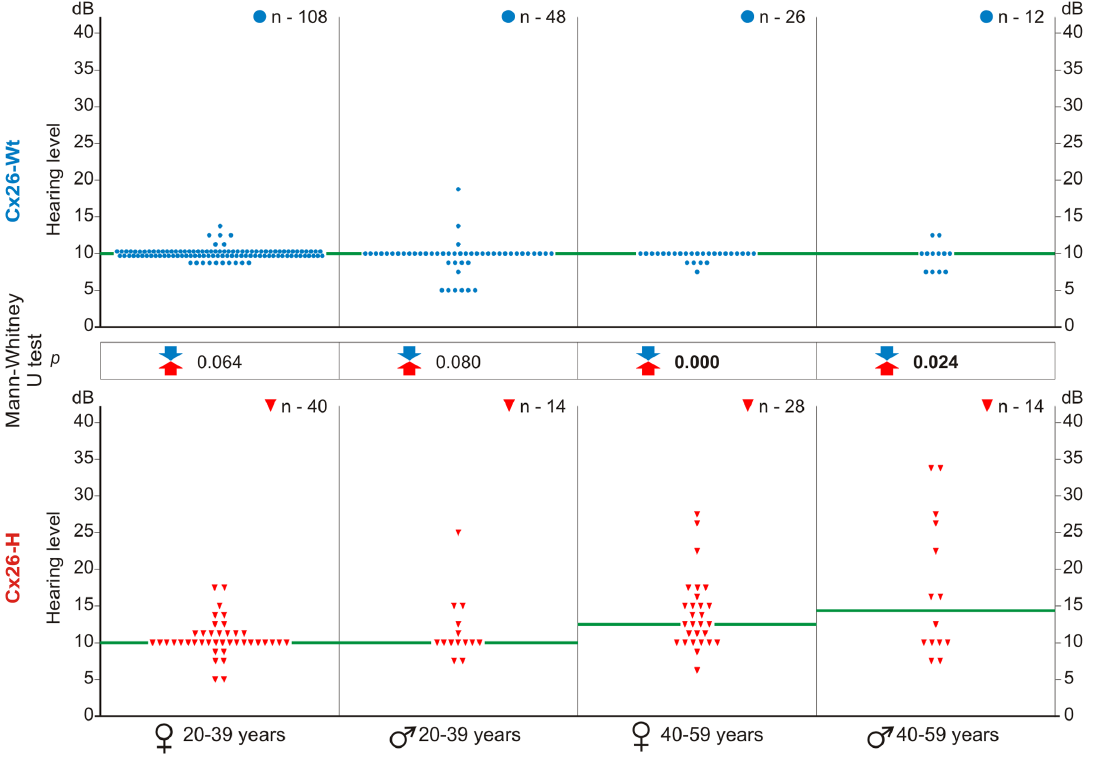
Figure 3. Scatter plots of the hearing thresholds at PTA 0.5, 1.0, 2.0, 4.0 kHz of individuals from compared Cx26-Wt and Cx26-H subgroups according to sex and age. Note: Y-axis – hearing level (hearing threshold, dB). X-axis – audiometric parameters of individuals according to sex and age. Blue circle denotes an individual with GJB2 genotype wt/wt, red delta denotes an individual with GJB2 genotype IVS1 + 1G . A/wt; n – number of ears; statistically significant differences (p , 0.05) by the Mann-Whitney U test between the compared subgroups are shown in bold; median hearing thresholds are shown by green line. R – female; = – male. doi:10.1371/journal.pone.0100848.g003 PLOS ONE |